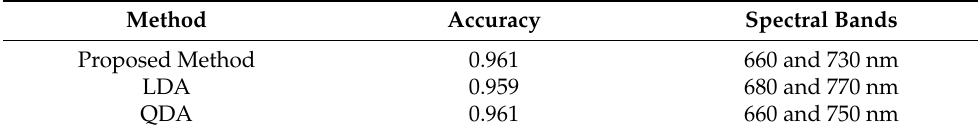
Table 3. Comparison of the accuracy assessment results.